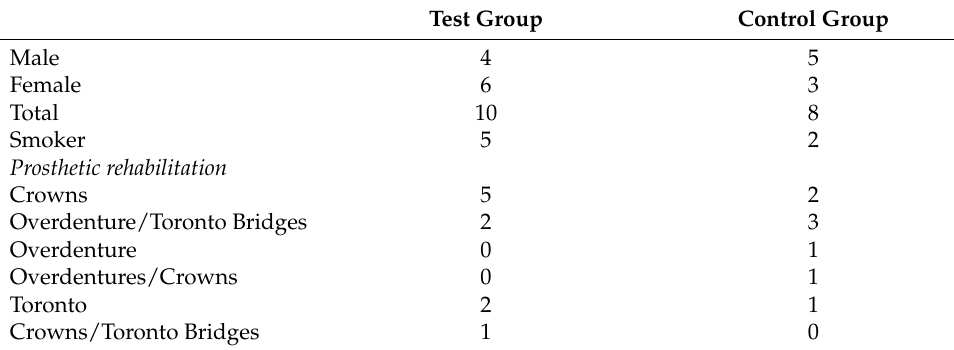
Figure 1. CONSORT flow chart of the clinical trial. Table 2. Summary of prosthesis data.